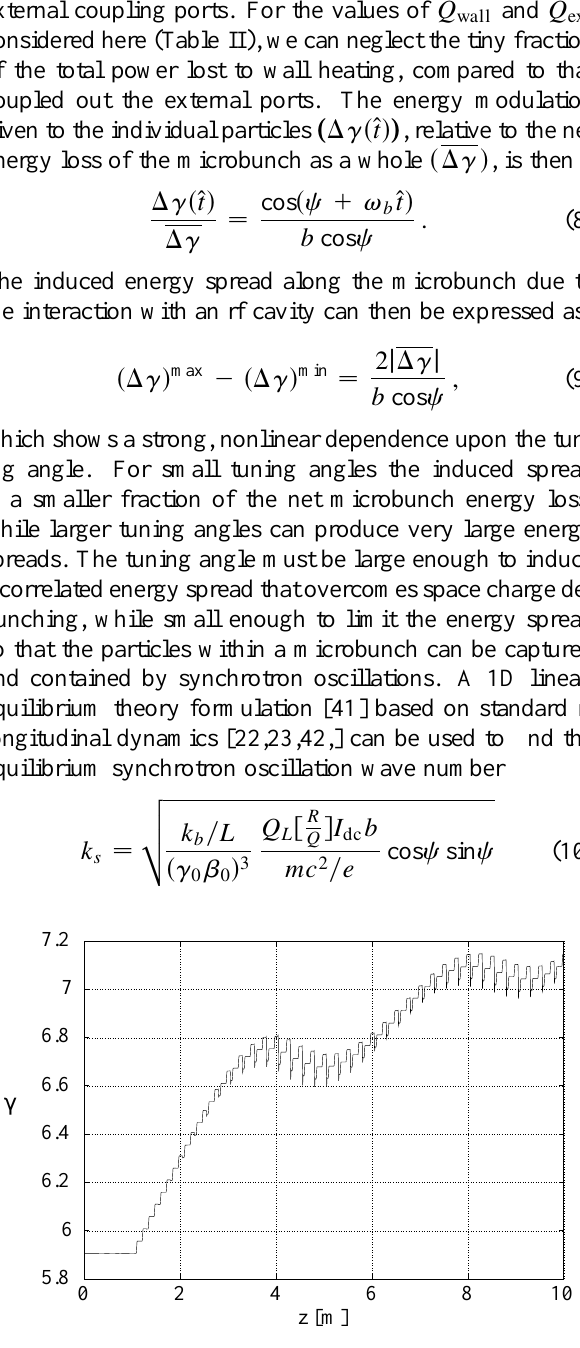
FIG. 8. Evolution of microbunch centroid energy along beam